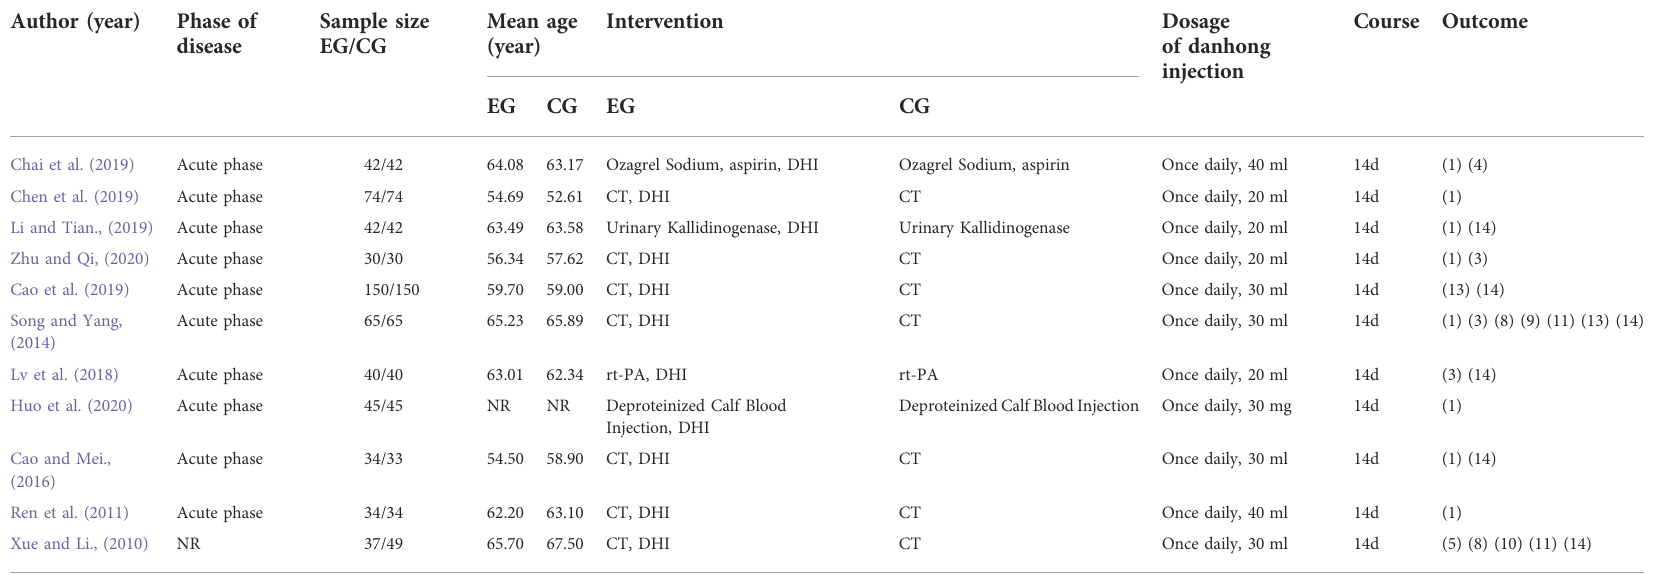
TABLE 1 ( Continued ) Baseline characteristics of included randomized controlled